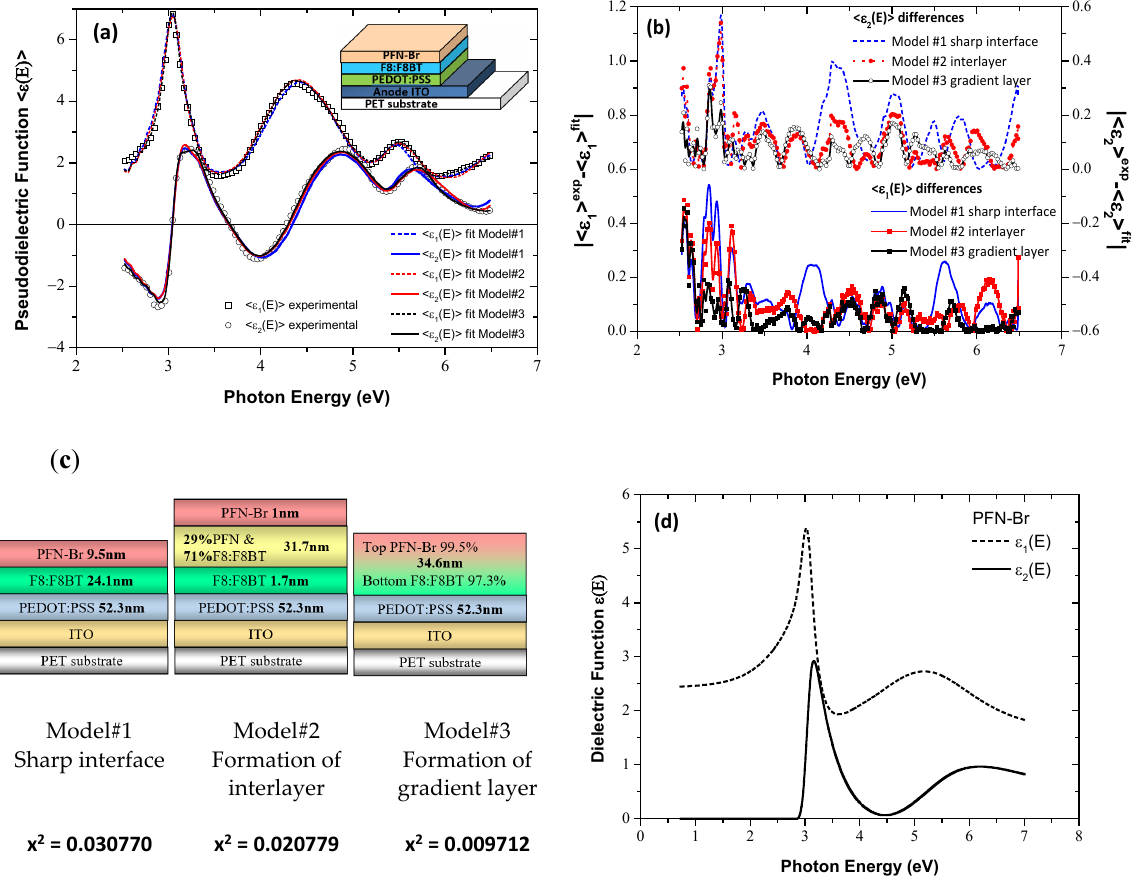
2.7% (97.3% F8:F8BT) at the bottom. Figure 5d depicts the calculated dielectric function spectrum of the PFN-Br using the best-fit results of the parameters of the dispersion equation, consisting of 2 modified TL oscillators, that was applied for the parameterization of its dielectric response.